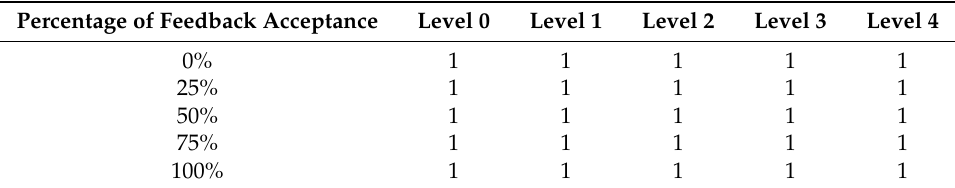
Table 2. User trust levels concerning efficiency when the devices do not make mistakes.